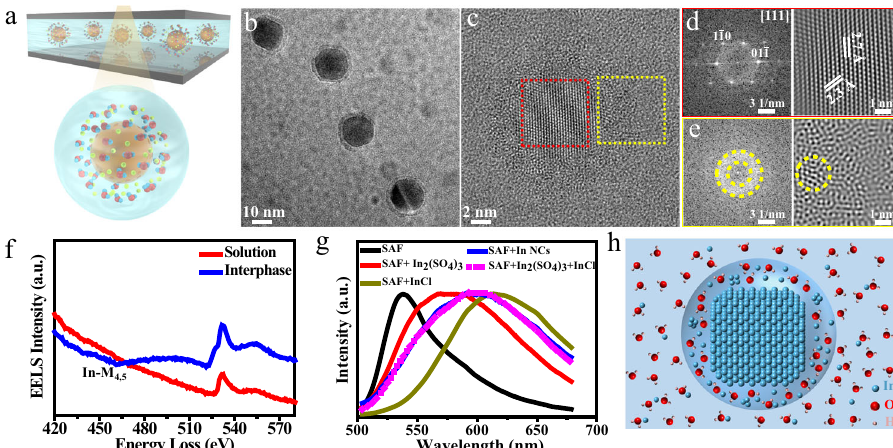
Fig. 1 Imaging and structure characterization of the quasi-liquid phase at the solid – liquid interface in liquid phase TEM. a Schematic illustration of In nanocrystals in aqueous solution. A quasi-liquid phase is observed on the surface of the In nanocrystals. The yellow, red and blue spheres represent In, O and H, respectively. The light blue, gray and yellow shading represent the liquid environment, liquid cell and electron beam, respectively. b Low- and c high- magni fi cation TEM image of In nanocrystals in aqueous solution. d Fast Fourier Transformed (FFT) and Inverse Fast Fourier Transformed (IFFT) image from the core region enclosed in the red dashed square in c . e FFT and IFFT image from the solid – liquid interface region enclosed in the yellow square in c . The yellow ring area is the masked area for IFFT. TEM image analysis indicated that the core was crystalline, and the quasi-liquid phase was amorphous. f EELS spectra of the quasi-liquid phase (blue line) and surrounding solution (red line). In and O were both detected in the quasi-liquid phase. g Fluorescence spectra of SAF (black line) in the presence of In nanocrystals (blue line), In 2 (SO 4 ) 3 (red line), InCl (golden line), and a mixed solution of In 2 (SO 4 ) 3 and InCl (dashed pink line). The peak at 598 nm is attributed to the interaction between the interphase and SAF solution. h Model of In crystal with amorphous quasi-liquid phase in solution. The amorphous phase consists of In-ions, small In clusters, water and hydroxyl